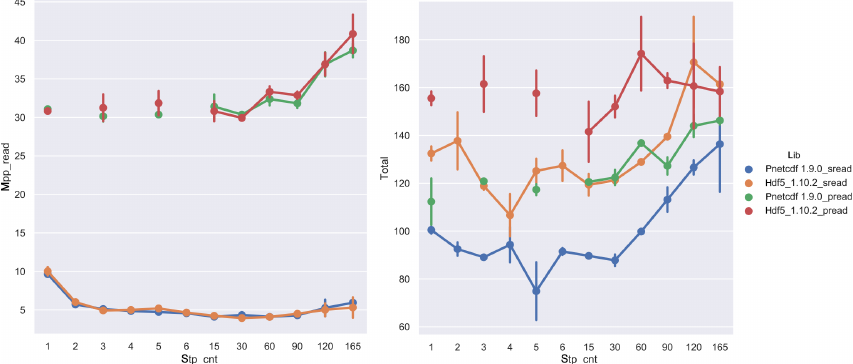
Figure 14. The 960 PE benchmarks with I / O layout = 4 × 30 and naggr = 1 by using serial read (sread) and parallel read (pread) with the HDF5 1.10.2 and PnetCDF libraries. Serial read times are overall more efficient over a range of stripe